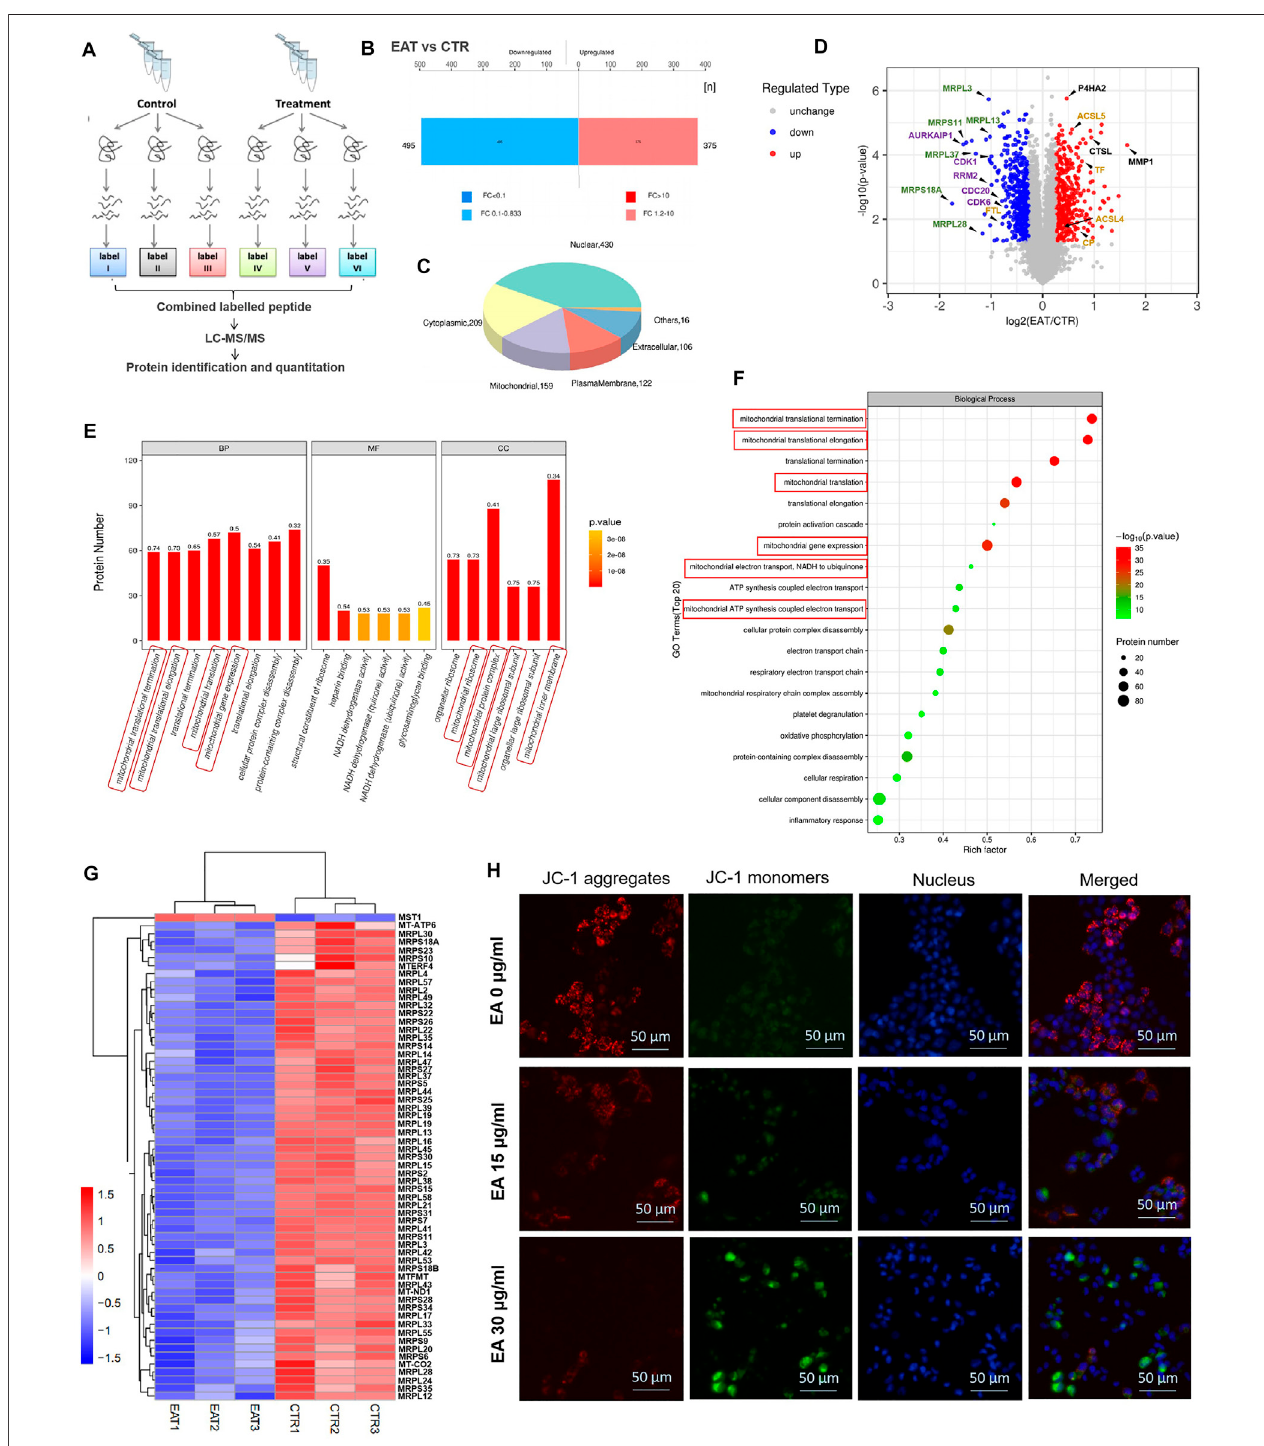
FIGURE 3 | The proteomics result indicated the main target molecule of EA was mitochondrial-associated protein. (A) A schematic diagram of the process of proteomic analysis in this study. (B) Compared with control group, 495 proteins decreased and 375 proteins increased in the EA-treated group. (C) Sub-cellular localization of EA-induced proteins alteration. (D) Volcano plot of EA-induced proteins alteration. Red dots represent increased proteins, and blue dots represent decreasedproteins.Thegreenlabelwasformitochondrialribosomalproteins,purplewasforcellcycle-relatedproteins, yellowwasforferroptosisrelatedproteins, andblackwasforexamplesofotherproteins. (E) Inthetop20ofenrichmentanalysisofthebiologicalprocess,cellularcomponentandmolecularfunction,mitochondria- related pathways accounted for 40% (the mitochondria-related pathways were circled with red). The numbers above the bars indicate the Rich Factor. (F) In the top 20